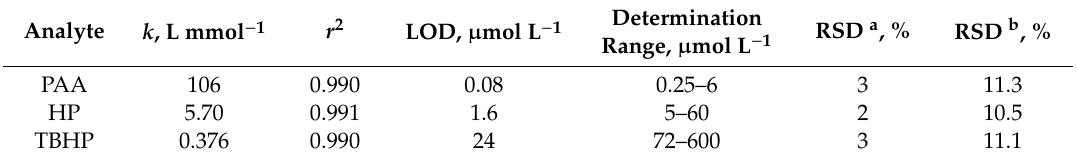
Table 2. Analytical features of the peroxides